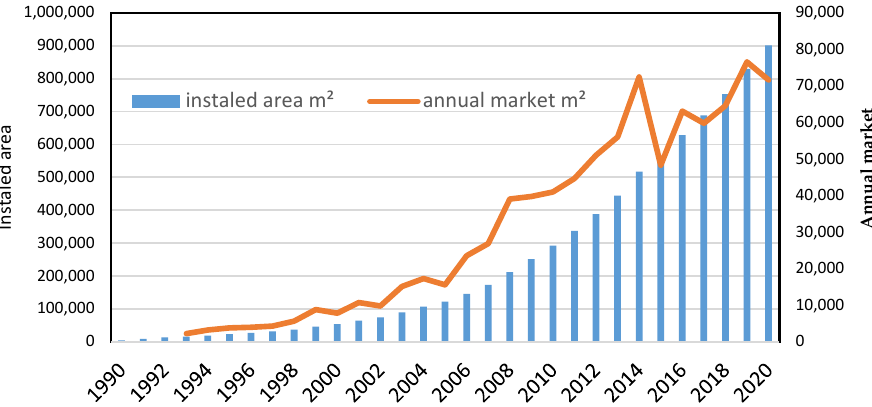
Figure 4. Evolution of the solar thermal collector’s cumulative area installed annually in Morocco vs. the national market (imported: installed and not installed).